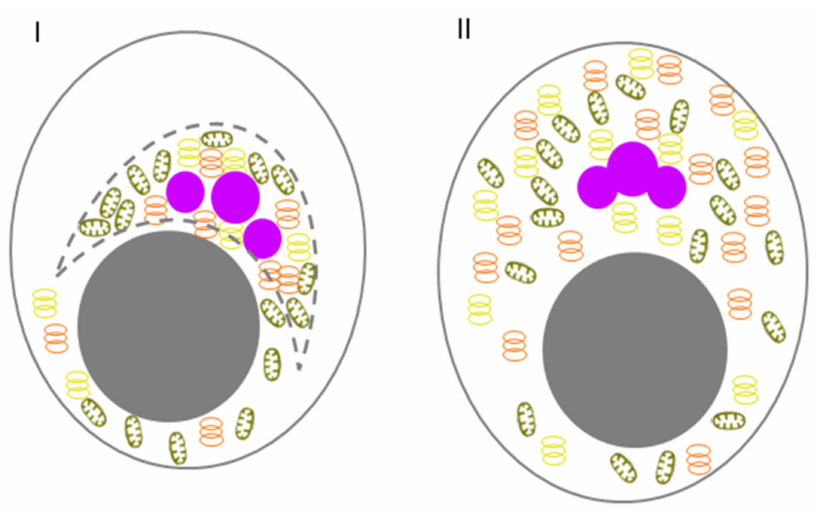
Figure 5. Schematic diagram of a Balbiani body in human. ( I ) An oocyte within a primordial follicle showing a Balbiani body. ( II ) An oocyte within a primary follicle. Germ cells are outlined with grey, and nuclei are shown as closed grey circles. Germ granules (closed purple circles). Mitochondria (brown ellipse). Golgi (yellow rings). Endoplasmic reticulum (ER) (orange rings). In ( I ), the Balbiani body is marked with a dashed